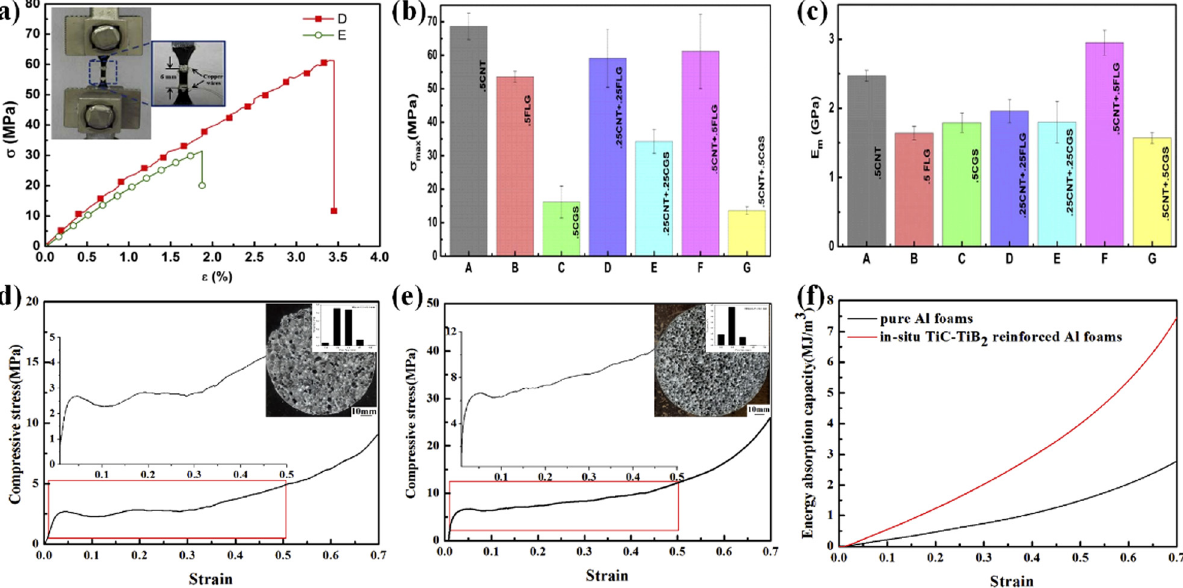
Figure 5: Mechanical properties of the nanocomposites. ( a ) Stress – strain curves for two selected materials of D ( 0.25 CNT + 0.25 FLG ) and E ( 0.25 CNT + 0.25 CGS ) , ( b ) elastic modulus, and ( c ) tensile strength [ 54 ] ( Copyright 2018, Elsevier ) . Compressive stress – strain curves and energy absorption capacity curves of pure Al foam and in situ TiC - TiB 2 - reinforced Al foam: ( d ) and ( e ) compressive stress – strain curves and pore structures ( inset of d and e ) , and ( f ) energy absorption capacity curves [ 57 ] ( Copyright 2020, Elsevier )